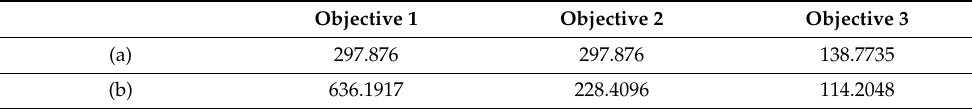
Figure 12. Two typical solutions in scenario 2. ( a ) One UAV is used to complete the MSR task. ( b ) Three UAVs are dispatched to complete the MSR task. Table 5. The typical objective